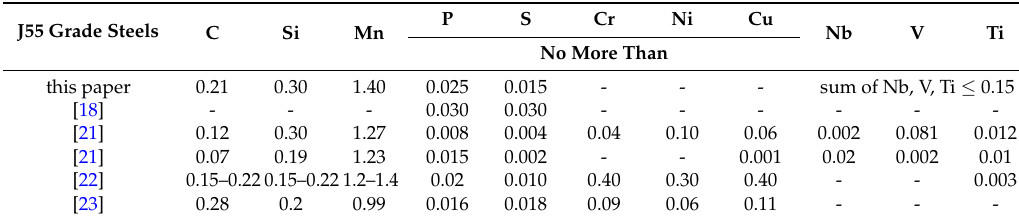
Table 6. Chemical compositions of J55-grade steels (wt